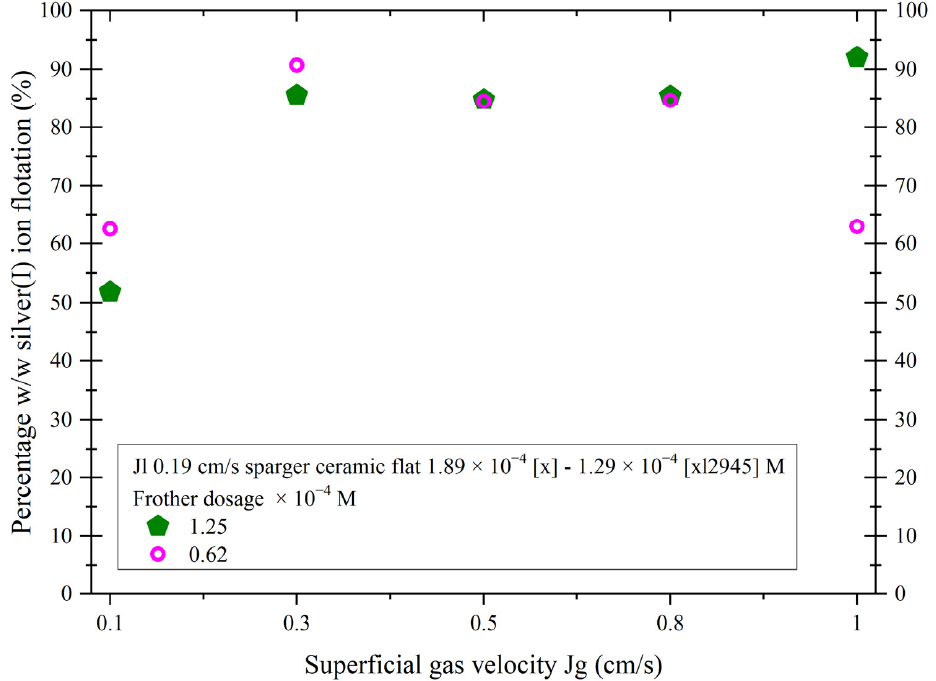
Figure 15. Percentage of w / w silver(I) recovery by ion fl otation as function of super fi cial gas velocity, 1.89 collector–1.29 promoter × 10 − 4 M. E ff ect frother dosage, 0.62 × 10 − 4 , and 1.25 × 10 − 4 M, Jl 0.19